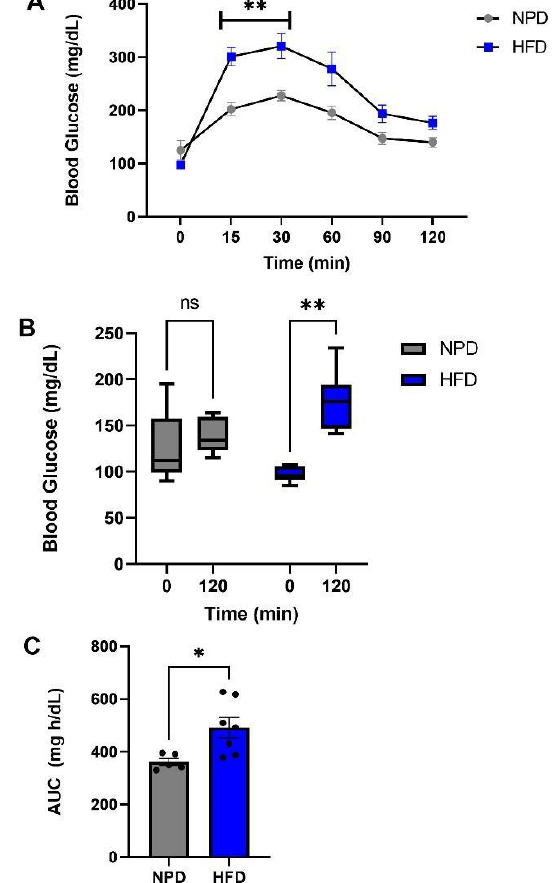
Figure 2. GTT test in NPD and HFD experimental groups after 8 weeks (T1) of HFD. ( A ) Glucose levels in GTT. Plasma glucose levels (mg/dL) differences between NPD and HFD groups for different times of GTT. ( B ) Glucose levels at 120 min. Plasma glucose levels (mg/dL) differences between NPD and HFD groups until 120 min after injection. ( C ) Area under the curve (AUC). Plasma glucose levels (mg/dL) per unit of time (h) difference between NPD and HFD groups. Statistical significance indicated for (*) p < 0.05 and (**) p < 0.01.